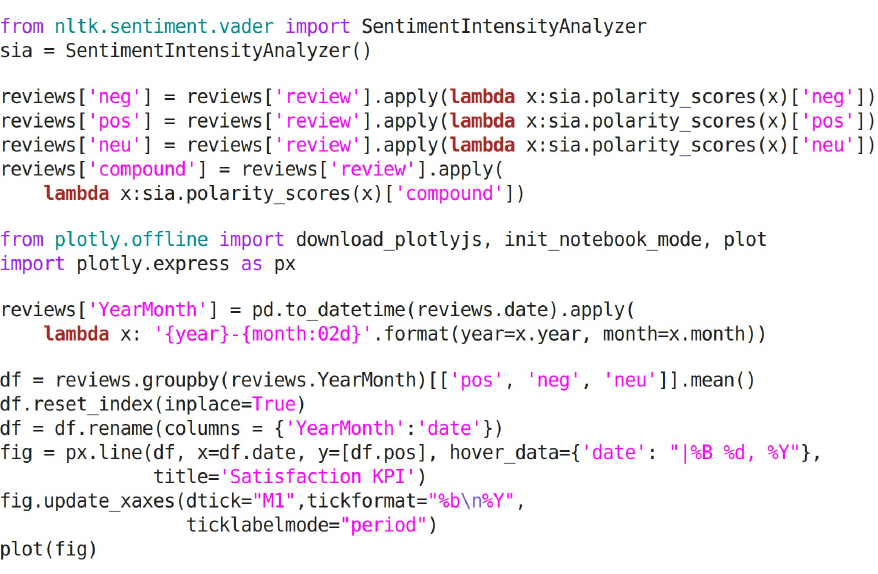
Figure 14. Application of sentiment analysis techniques to determine the Satisfaction KPI in